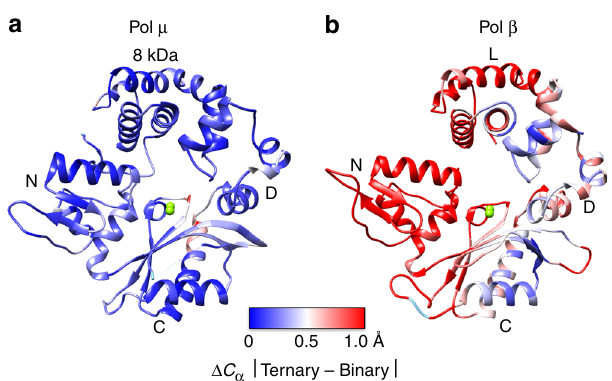
Fig. 1 Global conformational changes ( Δ C α ) upon binary-to-ternary complex transition in ( a ) pol μ and ( b ) pol β . The structures shown are the ternary complexes of each enzyme. The protein backbones are colored as a heat map from blue to red corresponding to changes in C α positions on a scale from 0 to 1.0Å, calculated from an alignment of the binary (PDB ids 4LZG and 3ISM for pol μ and pol β , respectively) and ternary (PDB ids 4M04 and 2FMS for pol μ and pol β , respectively) complexes using the Matchmaker tool in the Chimera package 46 . All the C α of the respective pol μ structures were used to perform the alignment, as pol μ does not display subdomain motions (RMSD, 0.23Å). In contrast, since the N-subdomain of pol β undergoes repositioning when a nucleotide binds to form the ternary complex (Fig. 4a in ref. 20 ), the alignment was restricted to the other pol β subdomains (RMSD, 0.86Å, 224 residues). The domains/subdomains are indicated; the polymerase domain includes the D-, C-, and N-subdomains corresponding to the thumb, palm, and fi ngers of right-handed polymerases 20 , as well as the 8-kDa and lyase (L) domain of pol μ and β , respectively. Active site metals are shown as green spheres and the ends of the disordered loop region in pol μ are shown connected by a dashed line ( cyan